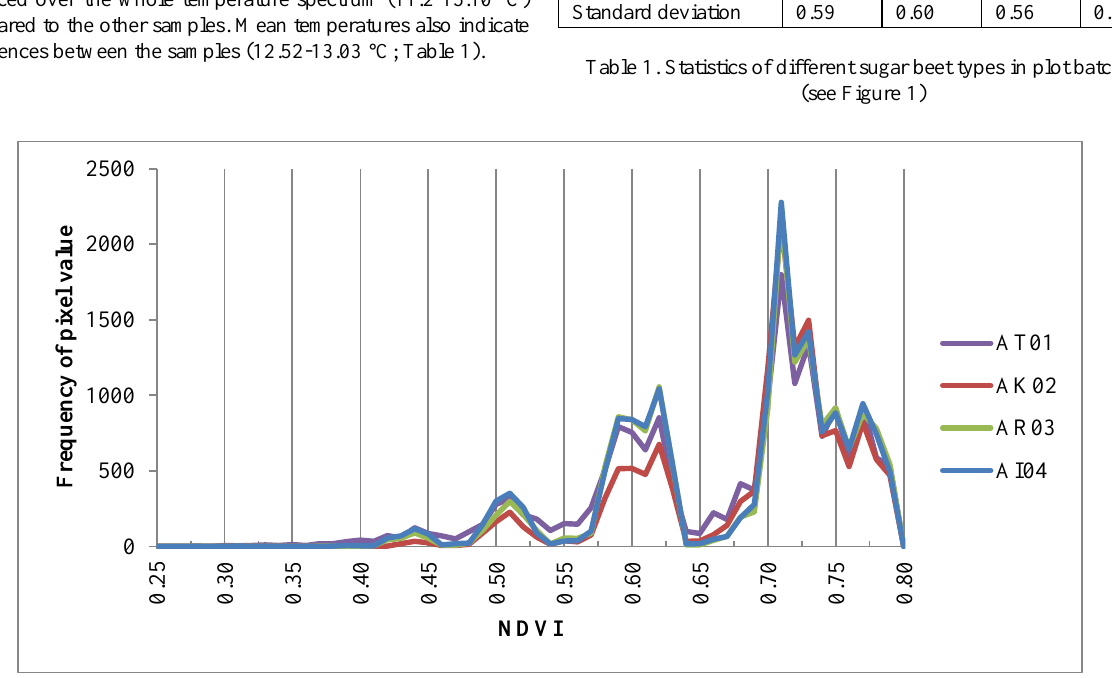
Figure 6. Histogram of measured NDVI values of different sugar beet types in plot batch 2 (see Figure 1)